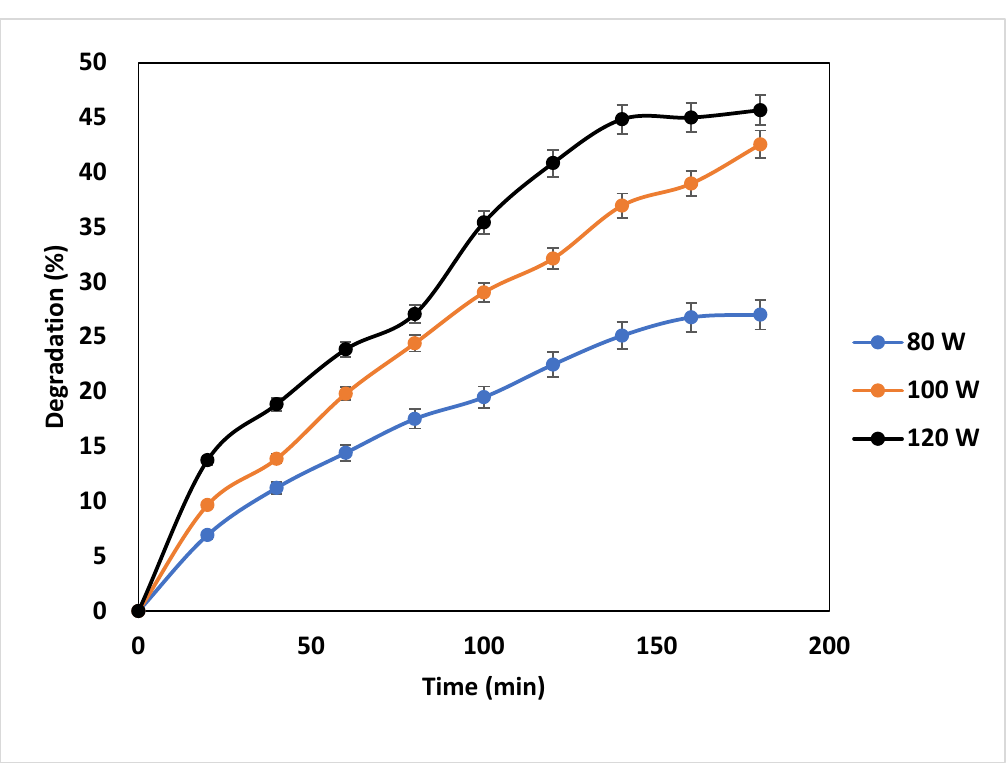
Figure 6. Effect of ultrasonic power on the degradation of Chrysoidine R dye.